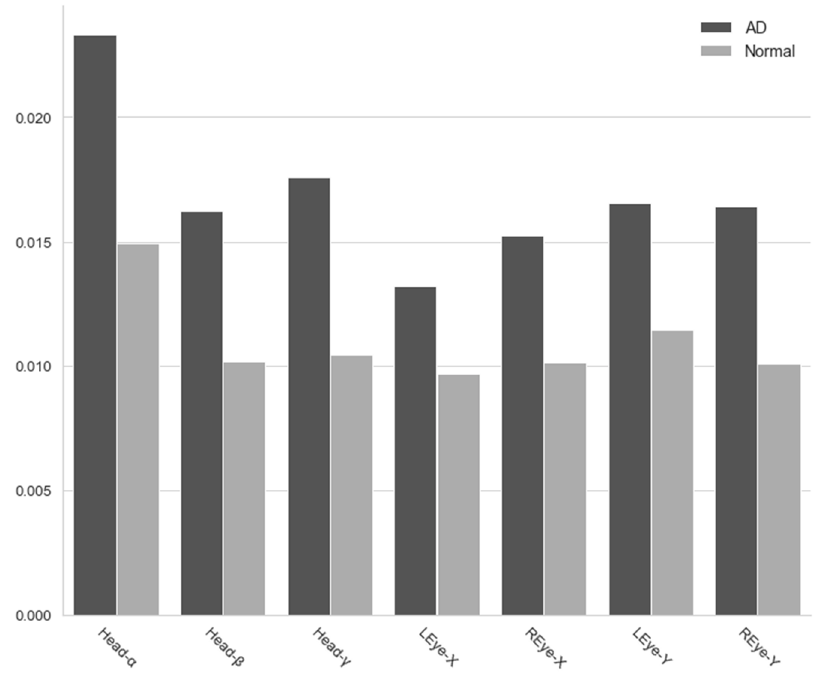
Figure 5. Variance for movement in all directions.